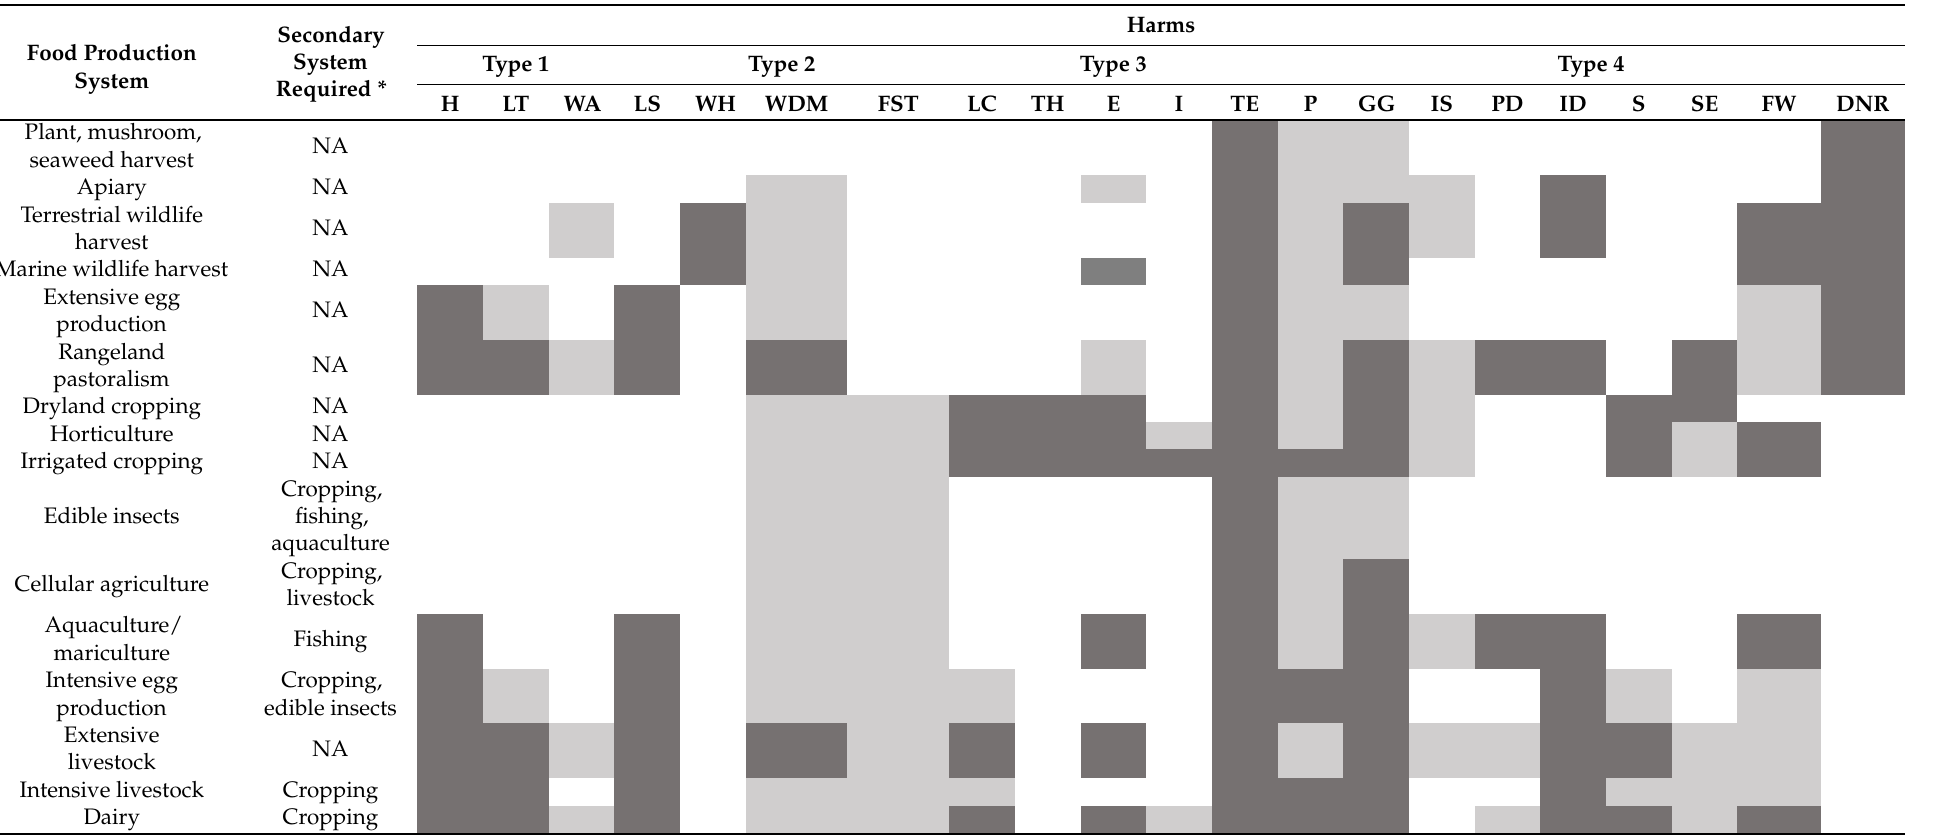
Table 1. Harms associated with food production systems. Shading indicates frequency of harms: white = none, light grey = inconsistent, and dark grey =